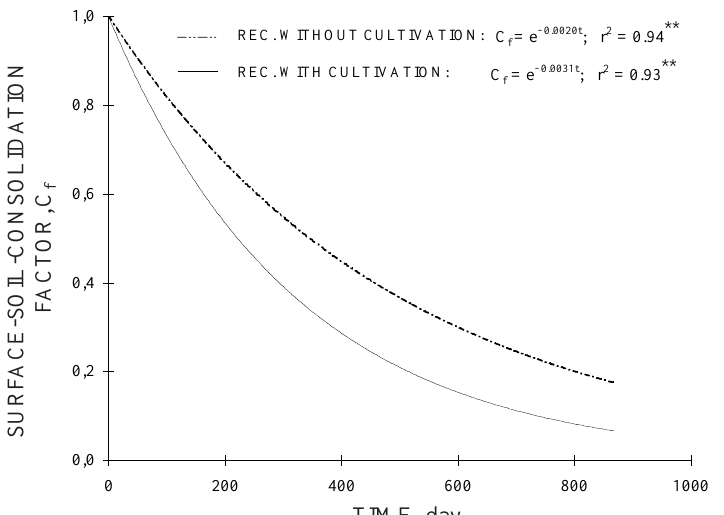
Figure 7. Surface-soil-consolidation factor as a function of time in the reconsolidating soil